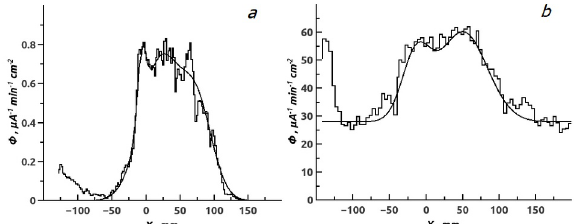
Fig. 3. Spatial neutron distribution from the moderator channel along the X-axis which was measured by: (a) 10 B-detector at U = 700 V; (b) the moving 3 He tube counter at U = 1400 V